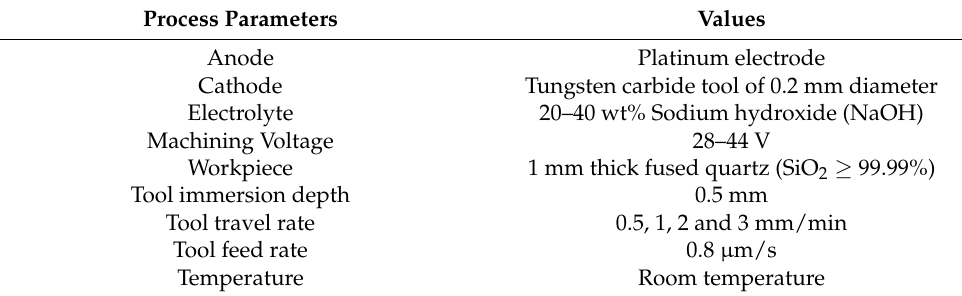
Figure 1. Schematic of the ECDM setup used in the present work. Table 1. Experimental conditions used in the present study.